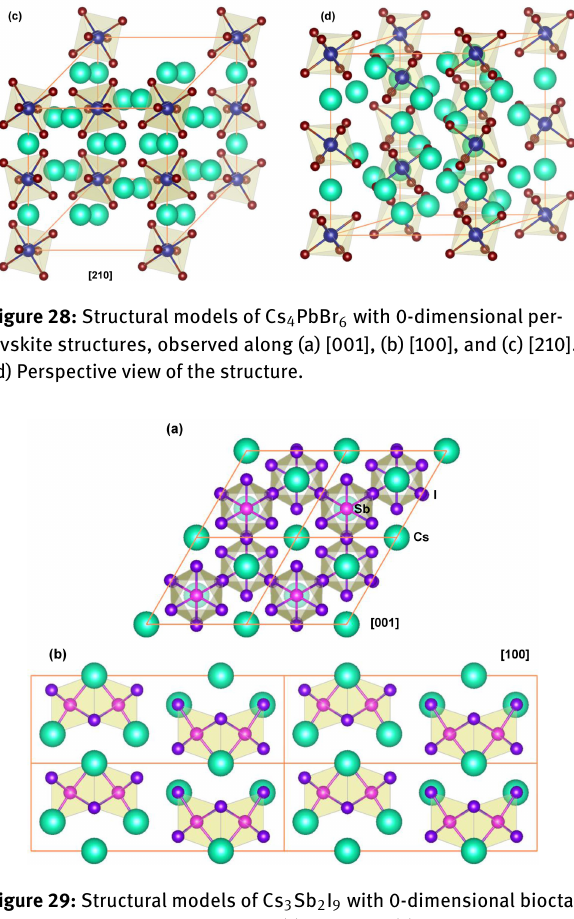
Figure 29: Structural models of Cs 3 Sb 2 I 9 with 0-dimensional biocta- hedra structures, observed along (a) [001] and (b)